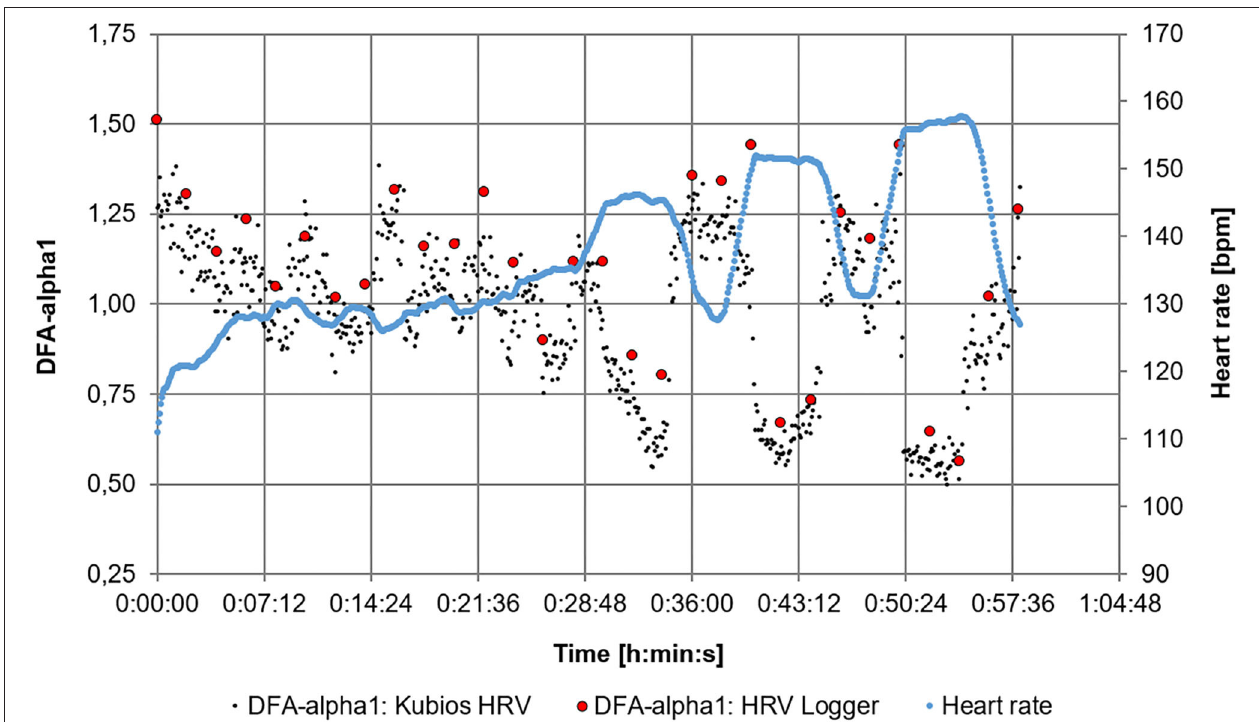
FIGURE 5 | Comparison of DFA-alpha1 of the HRV Logger data export (2 min segments non-overlapped) and the raw data evaluation of the Garmin fit. file via Kubios HRV premium software (time-varying method, window width = 2min, grid interval = 5s) throughout the 1h training